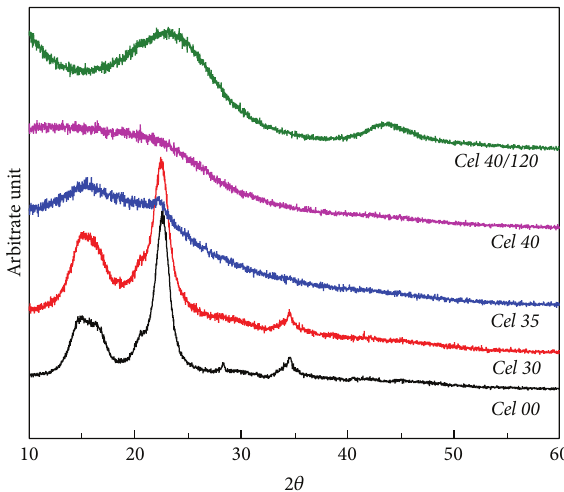
Figure 8: The FT-IR spectra of the heat-treated cellulose particles. treatment process for carbonization of the cellulose. Finally, the following conclusions were obtained.